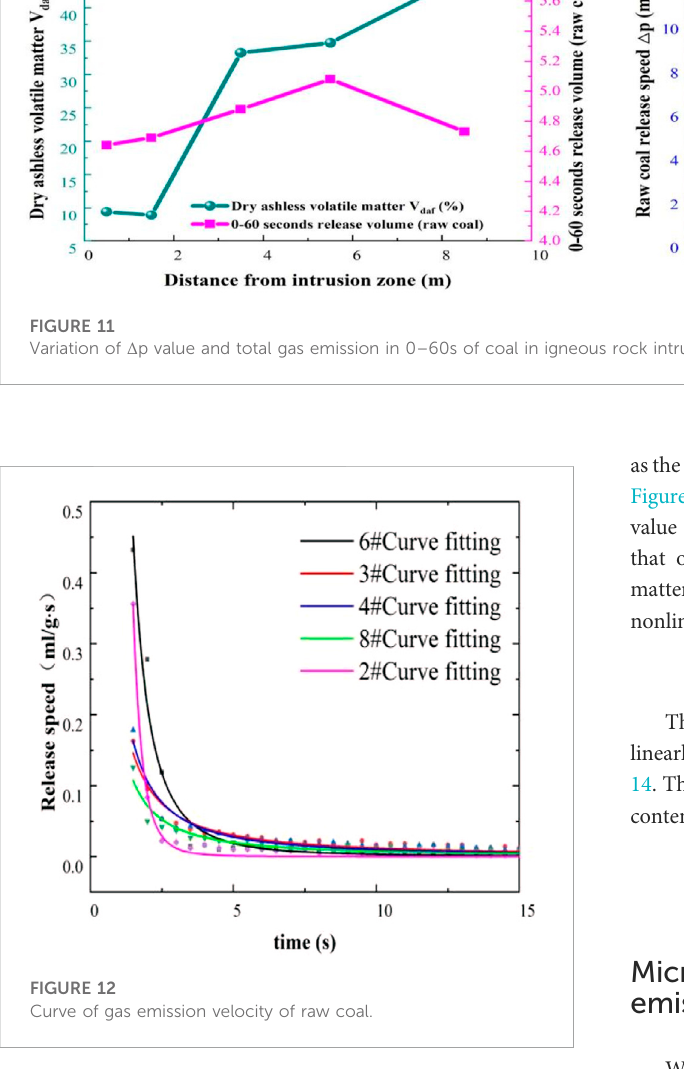
FIGURE 12 Curve of gas emission velocity of raw